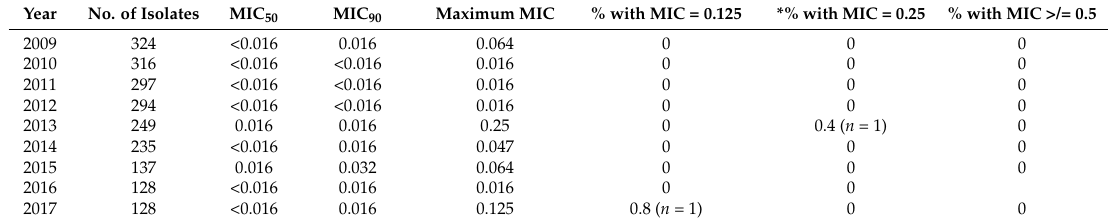
Table 3. Cefixime MIC trend analysis, Johannesburg, 2008–2017.